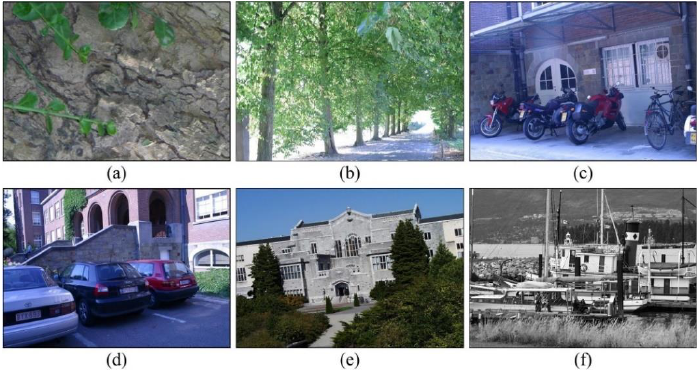
Figure 6. Base images provided by Oxford dataset. ( a ) Wall (viewpoint), ( b ) trees (blur), ( c ) bikes (blur), ( d ) Leuven (illumination), ( e ) Ubc (JPG compression), ( f ) boat (rotation and scale).